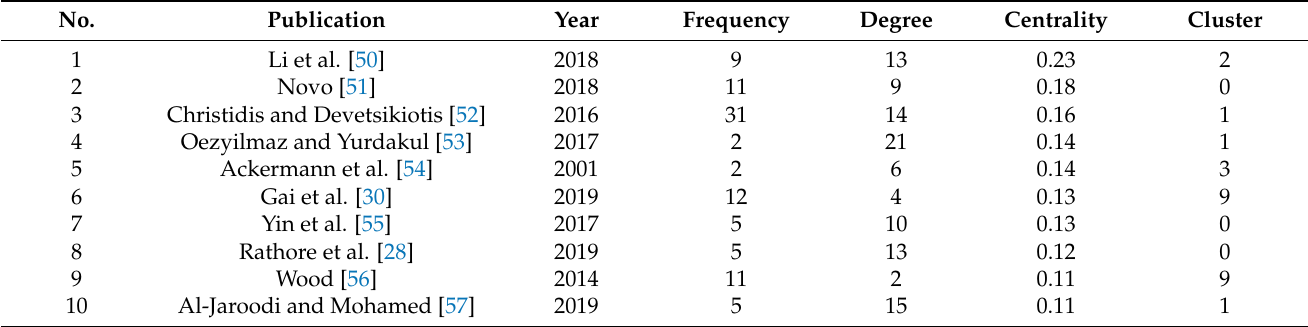
Table 7. Top ten co-cited documents with the highest betweenness centrality scores.